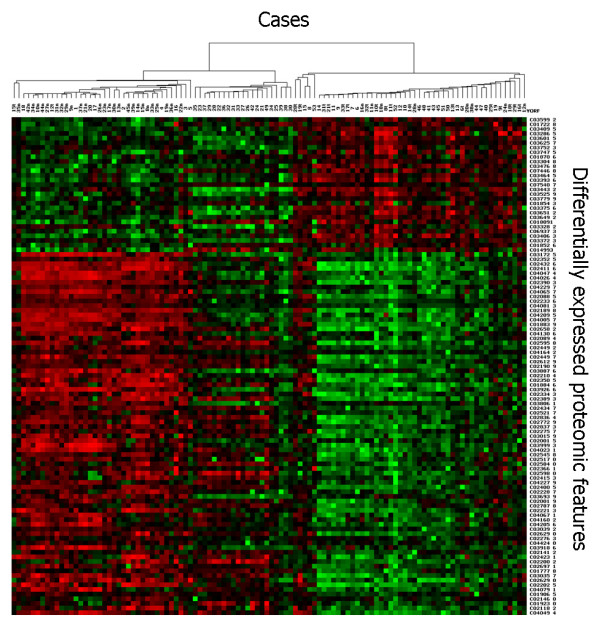
Expression difference map of gastric fluid and pellet extract proteins of validation set samples on four ProteinChip arrays, displayed in two-way hierarchical clustering. Significant proteomic features are displayed horizontally. The intensity of the red or green colours indicates the degree of relative protein level, higher or lower than the median value. Patient cases are presented vertically; most gastric cancer patients are tightly clustered together.